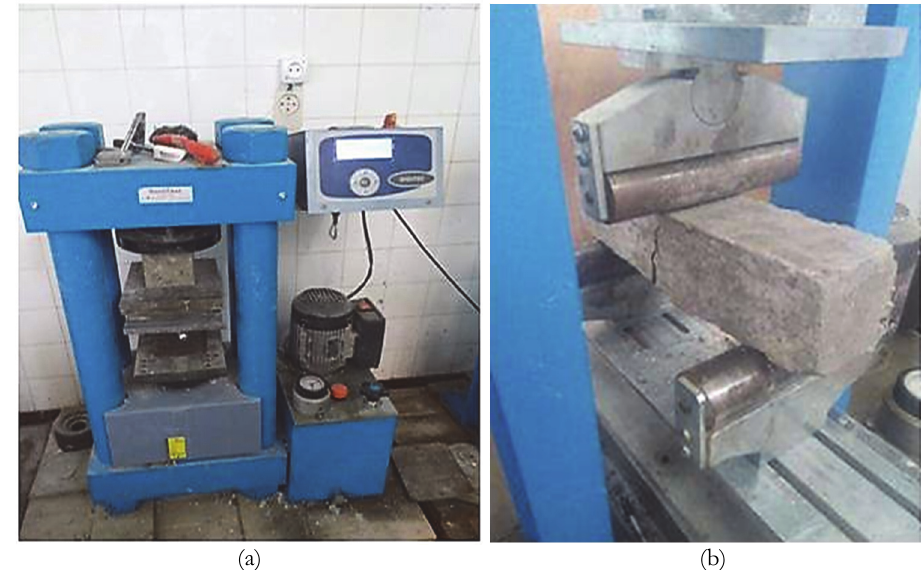
Figure 11: Hydraulics presses: (a) compression test and (b) three points bending